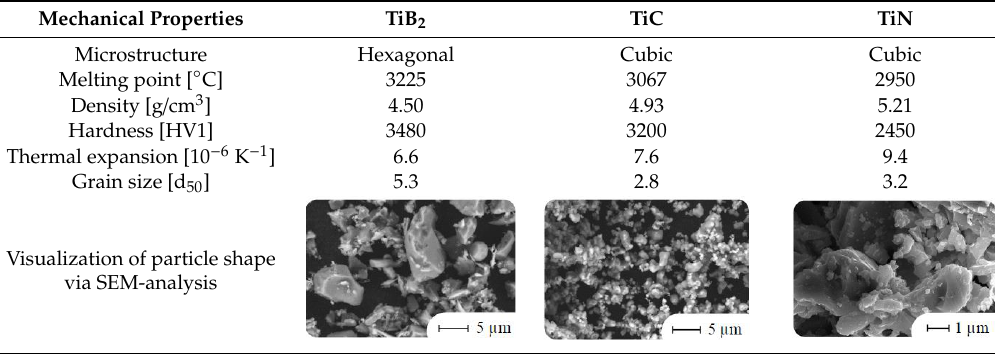
Table 2. Mechanical properties of the applied hard ceramic